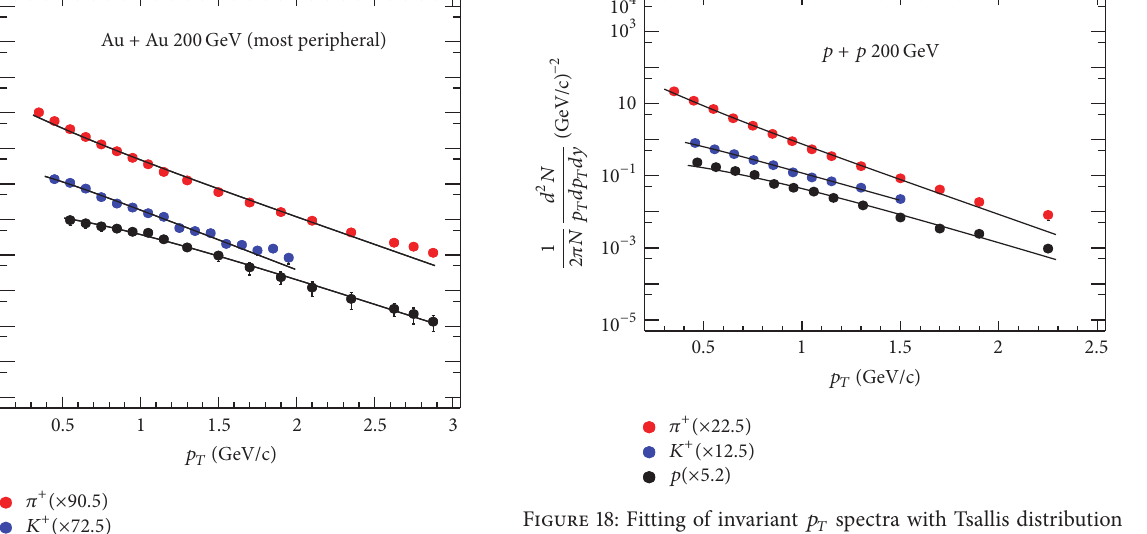
Figure 18: Fitting of invariant 𝑝 𝑇 spectra with Tsallis distribution including radial flow using (8) for 𝜋 + [21], 𝐾 + [21], and 𝑝 [21] in 𝑝+𝑝 collisions at √𝑠 NN = 200 GeV. Symbols represent the data points and the line is the fit function.